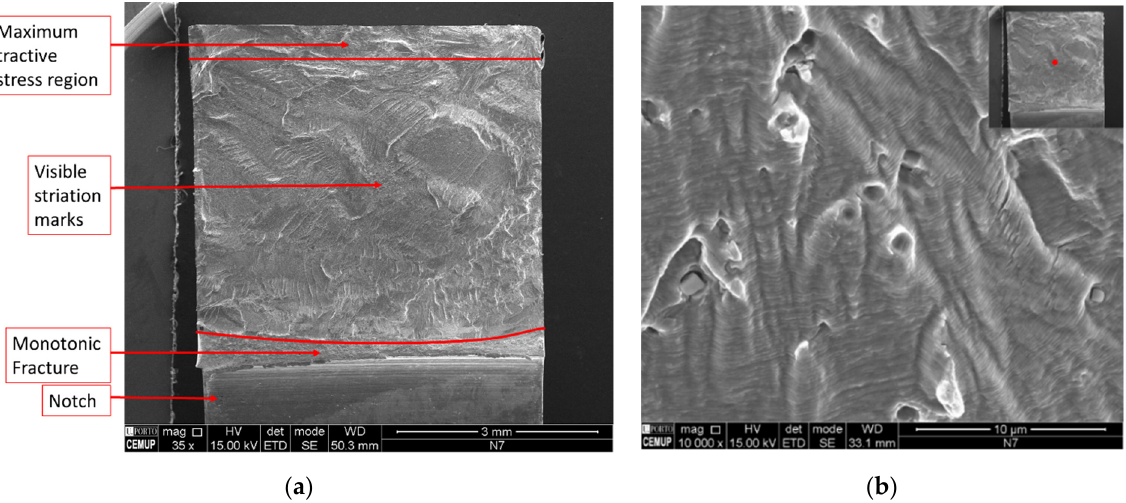
Figure 19. Fracture surfaces for miniature sample, N7, maximum FEM stress = 615 MPa: ( a ) Overview; ( b ) Striation marks view.